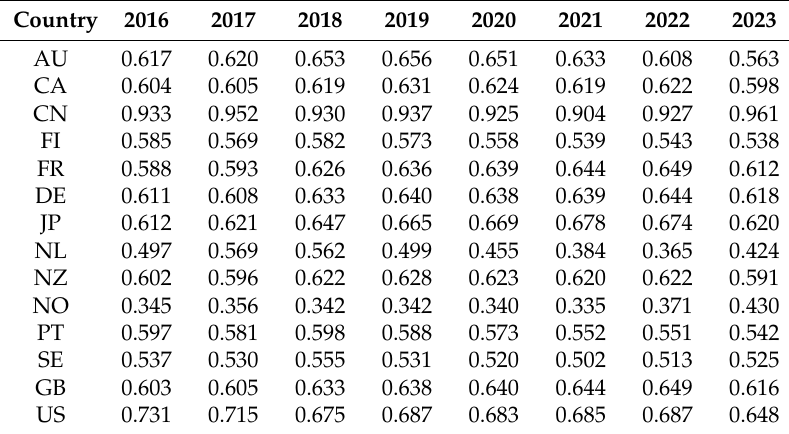
Table 12. Grade of electric vehicle